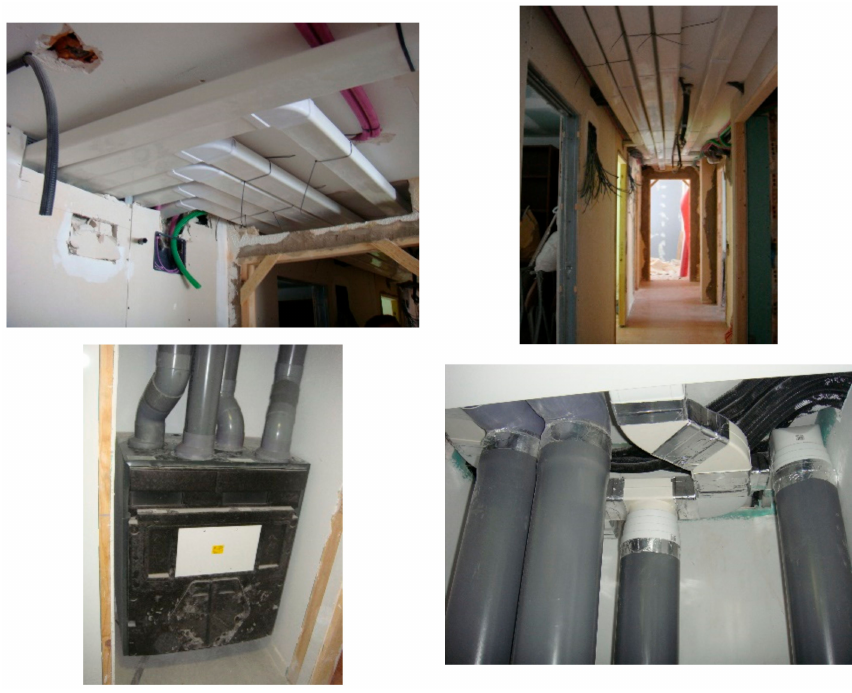
Figure 15. Double duct ventilation facility installed in the